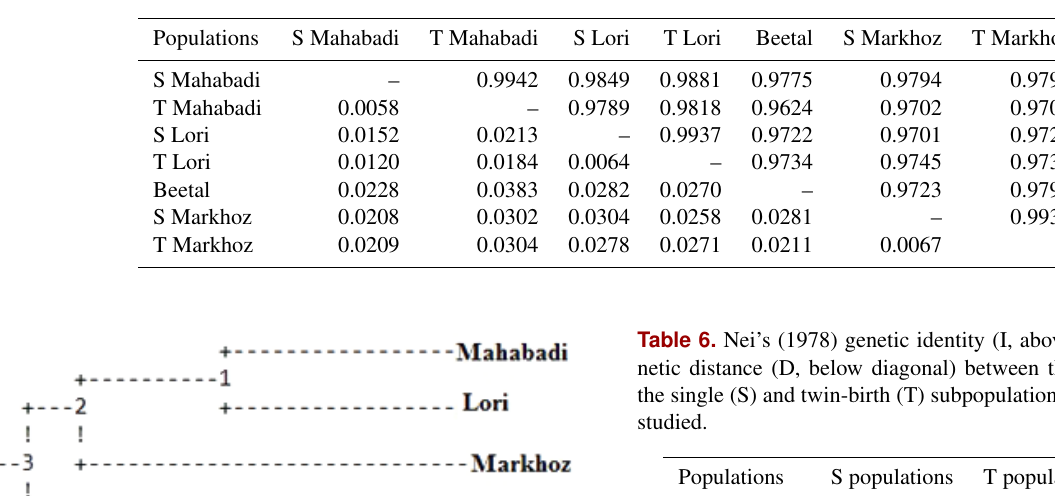
Table 5. Nei’s (1978) genetic identity (I, above diagonal) and genetic distance (D, below diagonal) between single (S) and twin-birth (T) subpopulations of goat breeds.